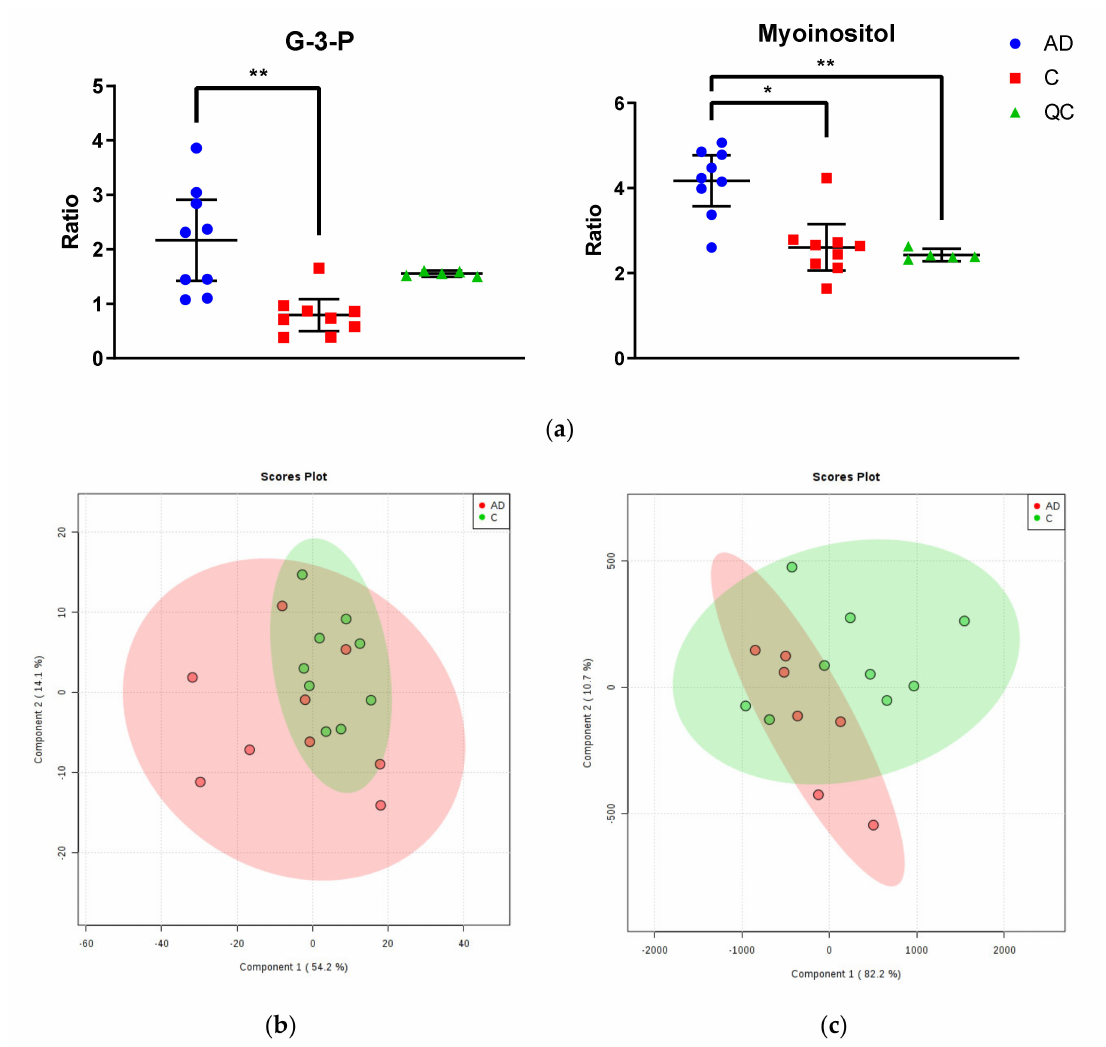
Figure 1. Metabolomic Analysis of Newcastle and Manchester Cohorts. ( a ) Glycerol-3-phosphate and myo-inositol were the only significantly altered metabolites between cases and controls in the Newcastle cohort. Graphs show ratios of significantly altered metabolites in comparison to internal standards within cingulate gyrus of cases (blue), controls (red) and quality control values (QCs; green). Error bars show ± 95% confidence intervals. Inter-group di ff erences calculated by Kruskal–Wallis test: * p < 0.05; ** p < 0.01 ( b ) PLS-DA plot of metabolites in cingulate gyrus of the Newcastle cohort. Cases are shown in red and controls in green. See Supplementary Materials C for labelled and unlabelled PCA and PLS-DA plots. ( c ) PLS-DA plot of metabolites in cingulate gyrus of the Manchester cohort. Cases are shown in red and controls in green. See Supplementary Materials C for labelled and unlabelled PCA and PLS-DA